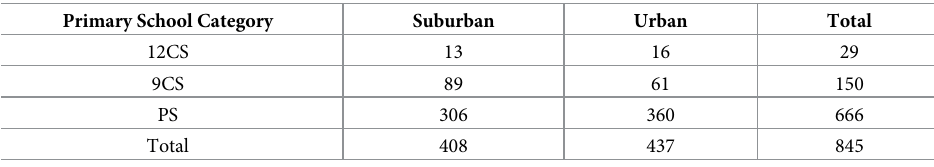
Table 1. Overview of primary education in Shanghai,